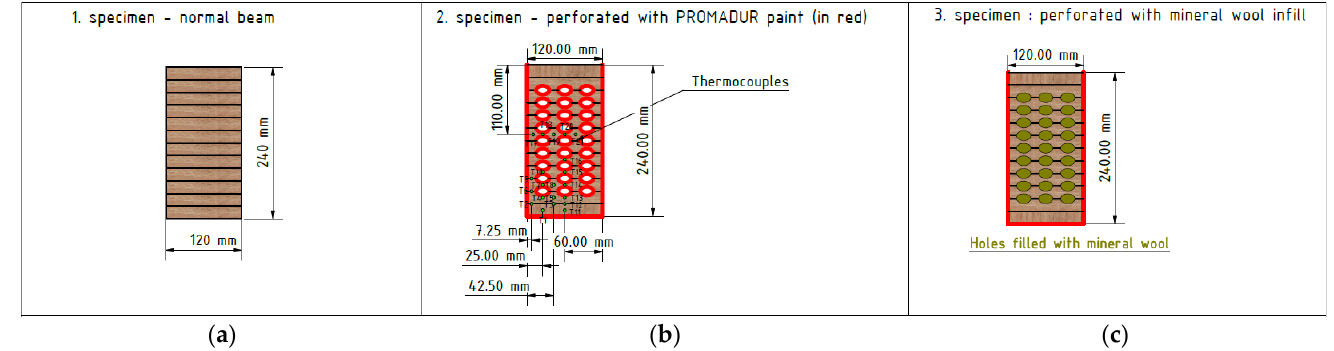
Figure 8. Specimen cross-section: ( a ) normal beam; ( b ) hollow with intumescent paint; ( c ) hollow with mineral wool infill.